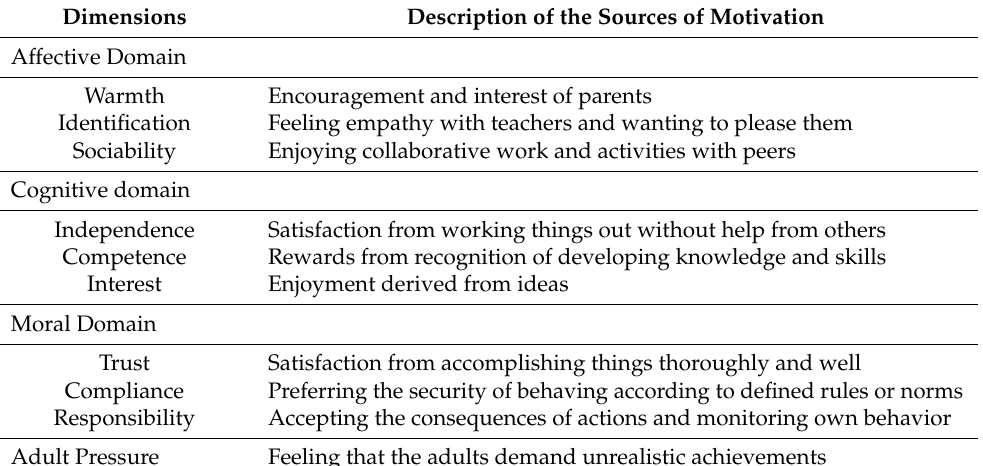
Table 1. Dimensions of learning motivation by Entwistle and Kozeki, reprinted with permission from Ref [17] (p. 244). Elsevier,